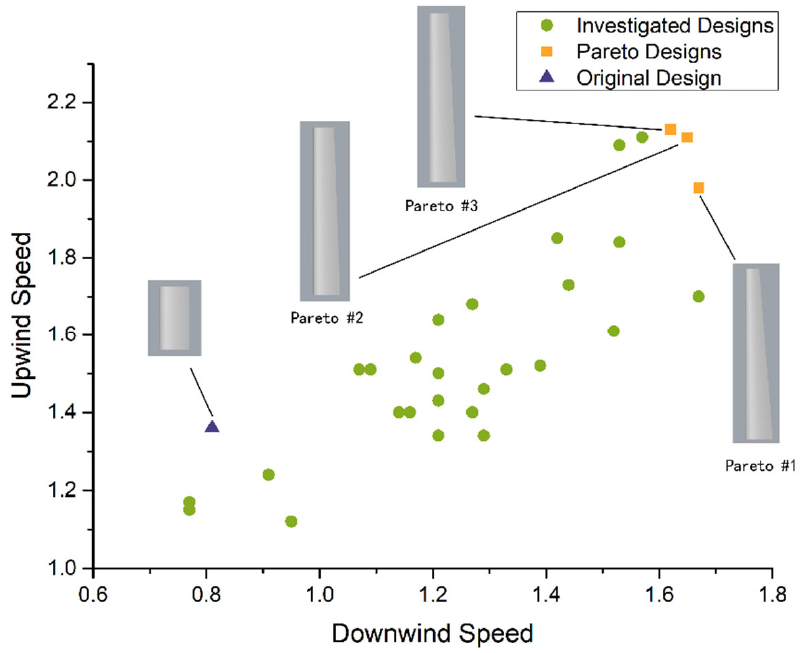
Figure 14. Pareto front of designs.